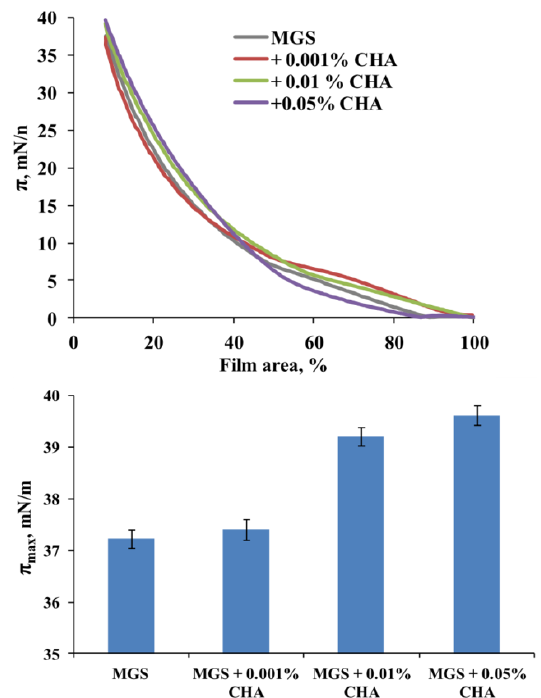
Figure 4. Effects of CHA on the surface properties of meibomian films. The upper panel shows the compression isotherm of meibomian (MGS) films in the presence of the polymer. The lower panel shows that CHA inclusion into the subphase results in a concentration-dependent increase of π max . The whiskers denote standard deviation ( n = 5).